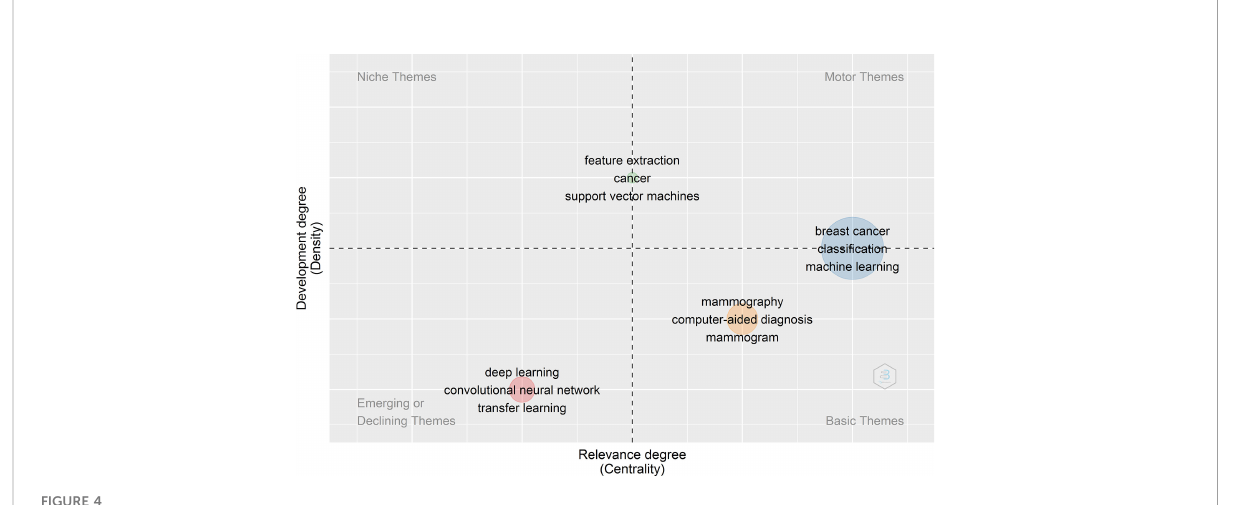
FIGURE 4 Thematic map of author's keywords.